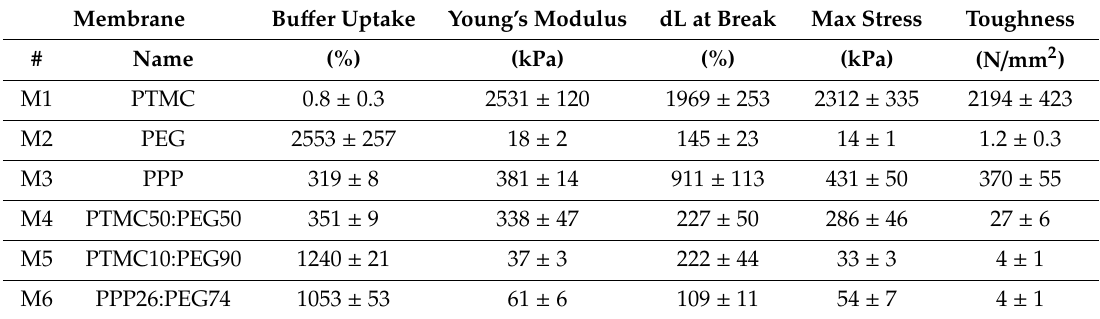
Table 3. Summary of the membrane characteristics. Reported values are mean ± SEM for at least five measurements.